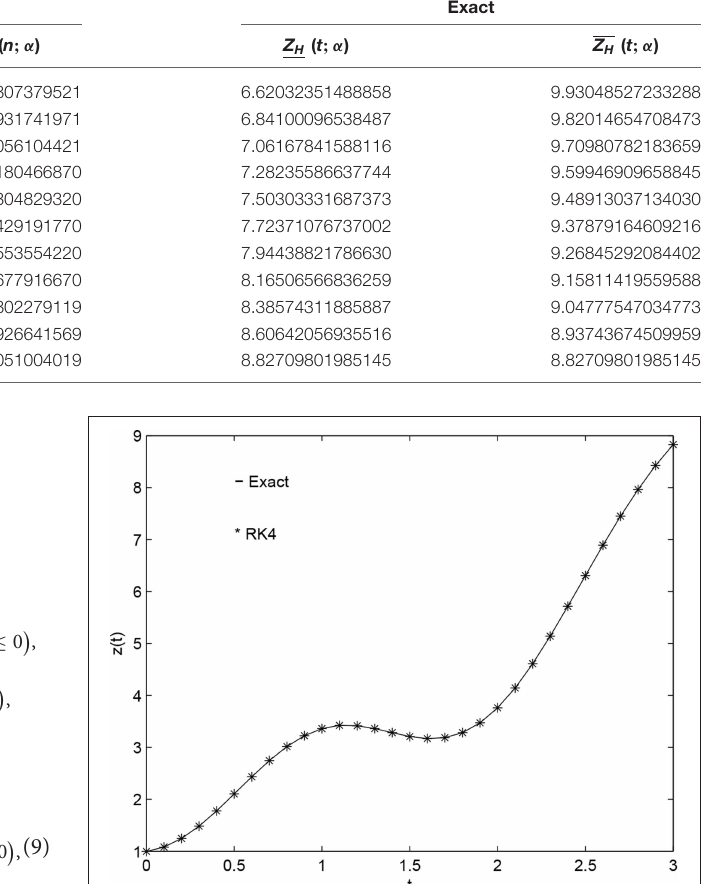
FIGURE 1 | Comparing approximate solution with the exact solution (for h = 0.1, α = 1 at t ∈